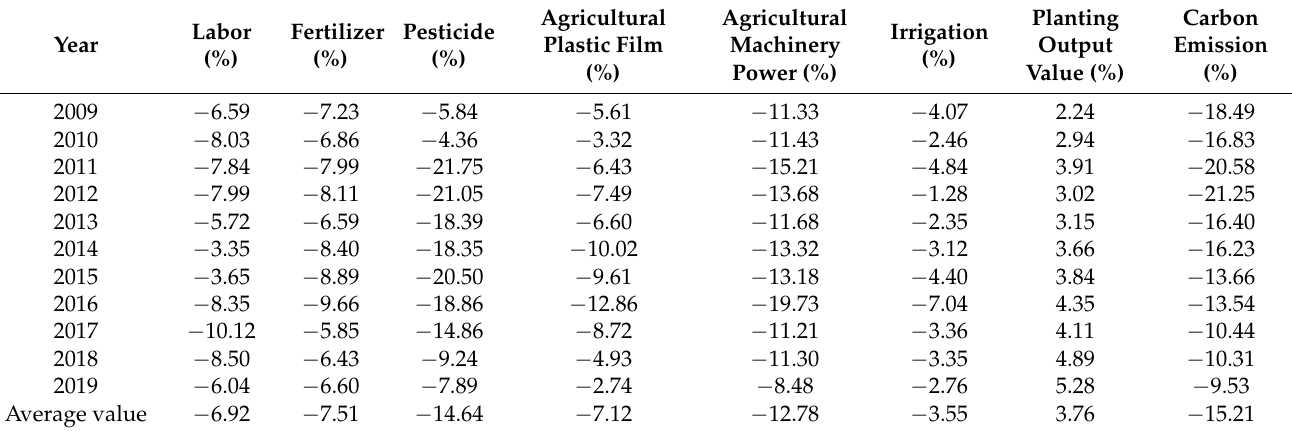
Table 3. Improvement ratio of input–output indicators of cultivated land use in China from 2009 to